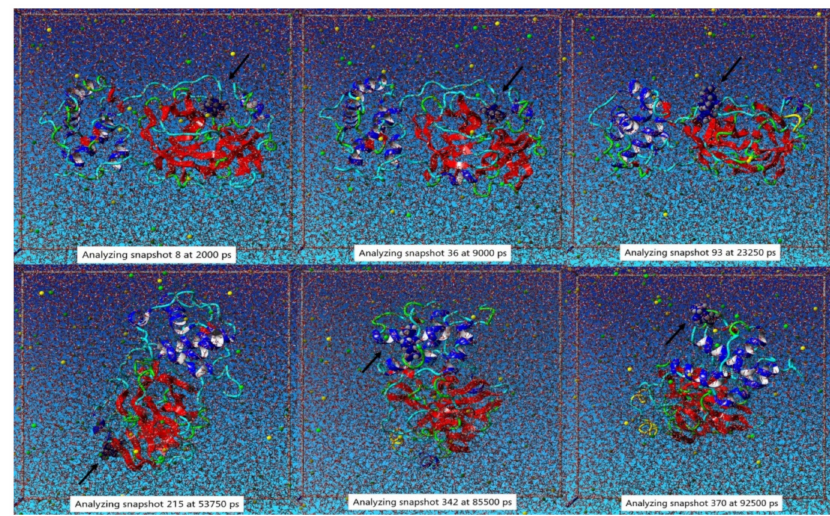
Figure 8. Snapshots of molecular dynamic simulation process of DTQ-3CLpro complex.